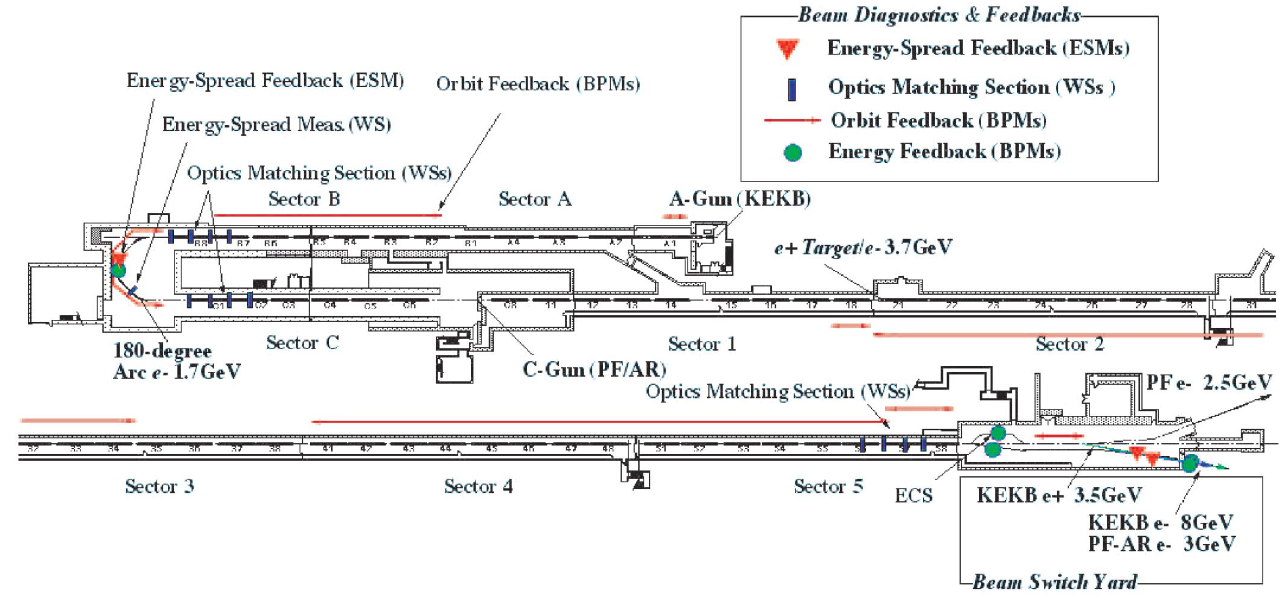
FIG. 4. (Color) Layout of the KEKB electron/positron injector linac and the location of the beam-feedback control systems.